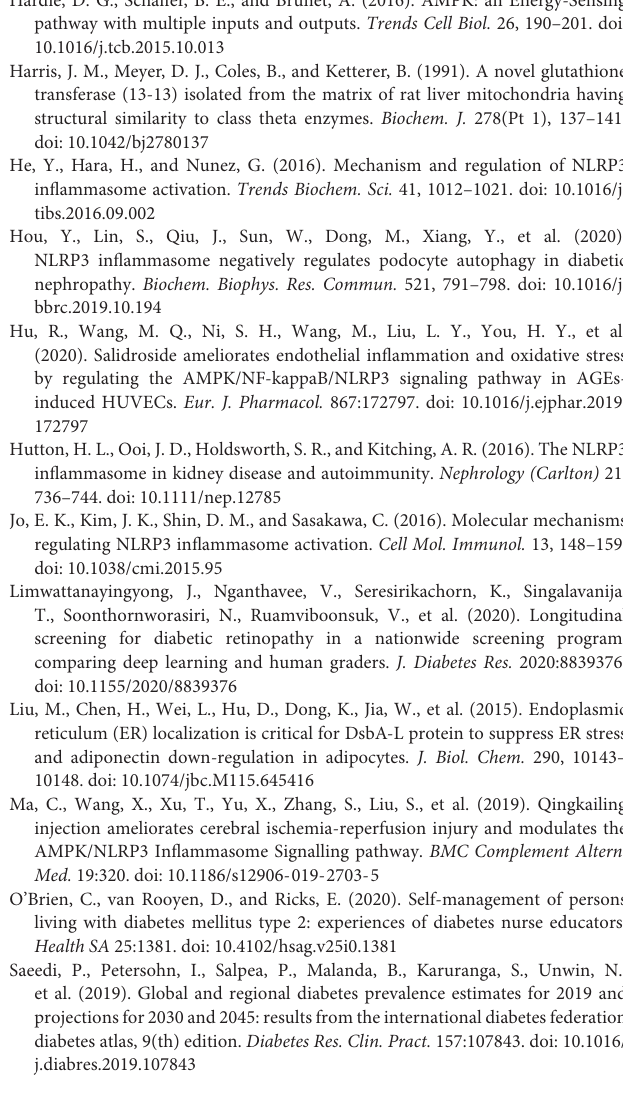
Supplementary Figure 1 | The expression of DsbA-L (A) in vivo and (B) in vitro